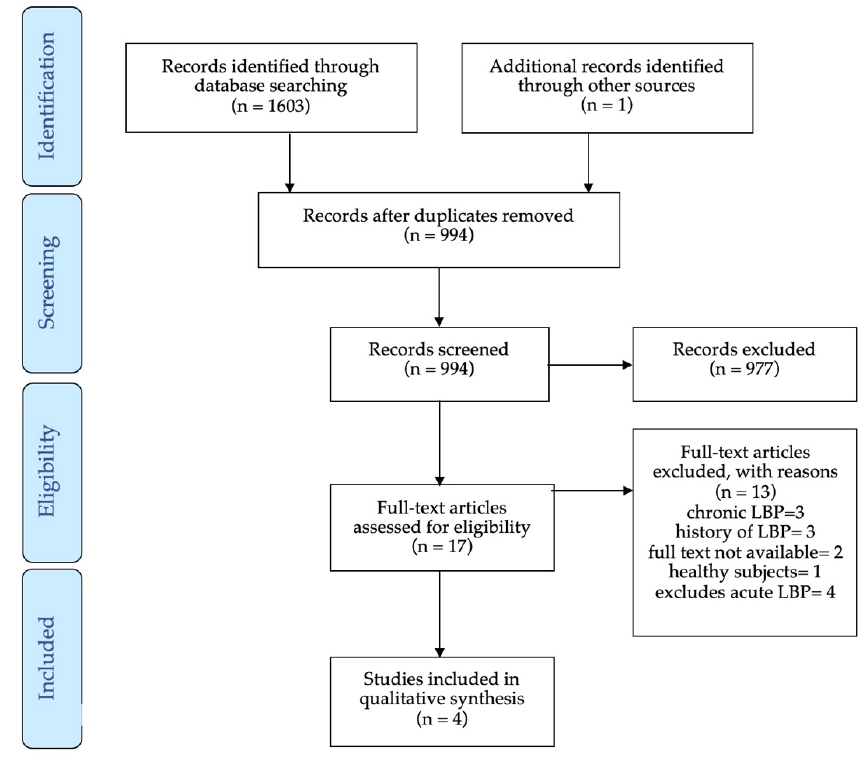
Figure 1. Flow chart for the systematic review.